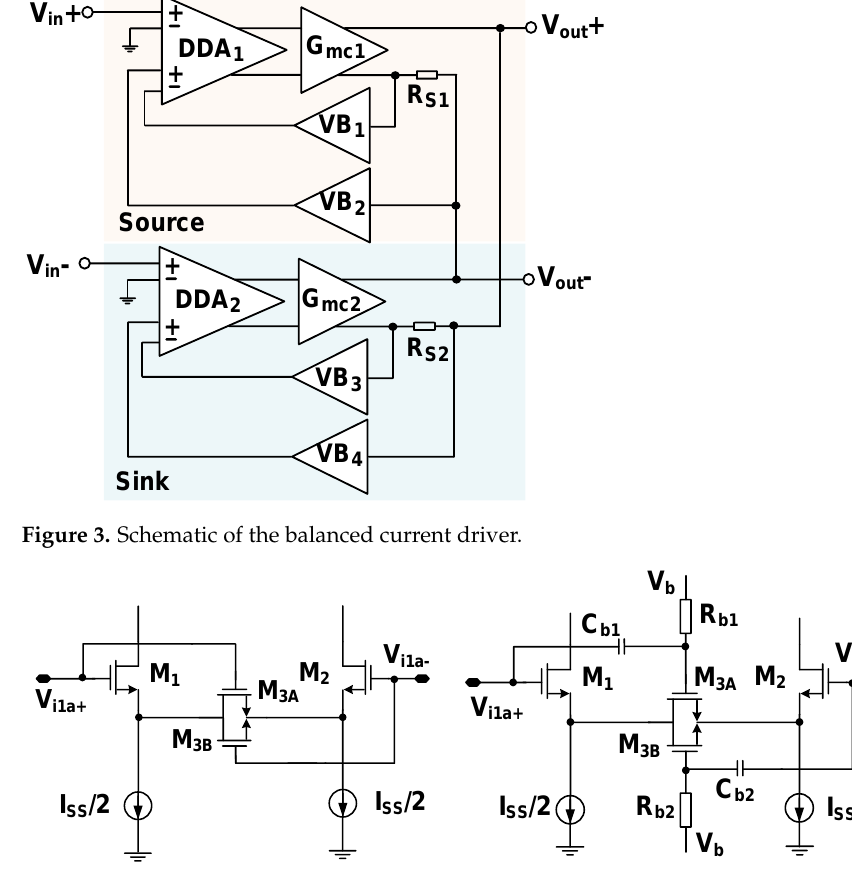
Figure 3. Schematic of the balanced current driver.